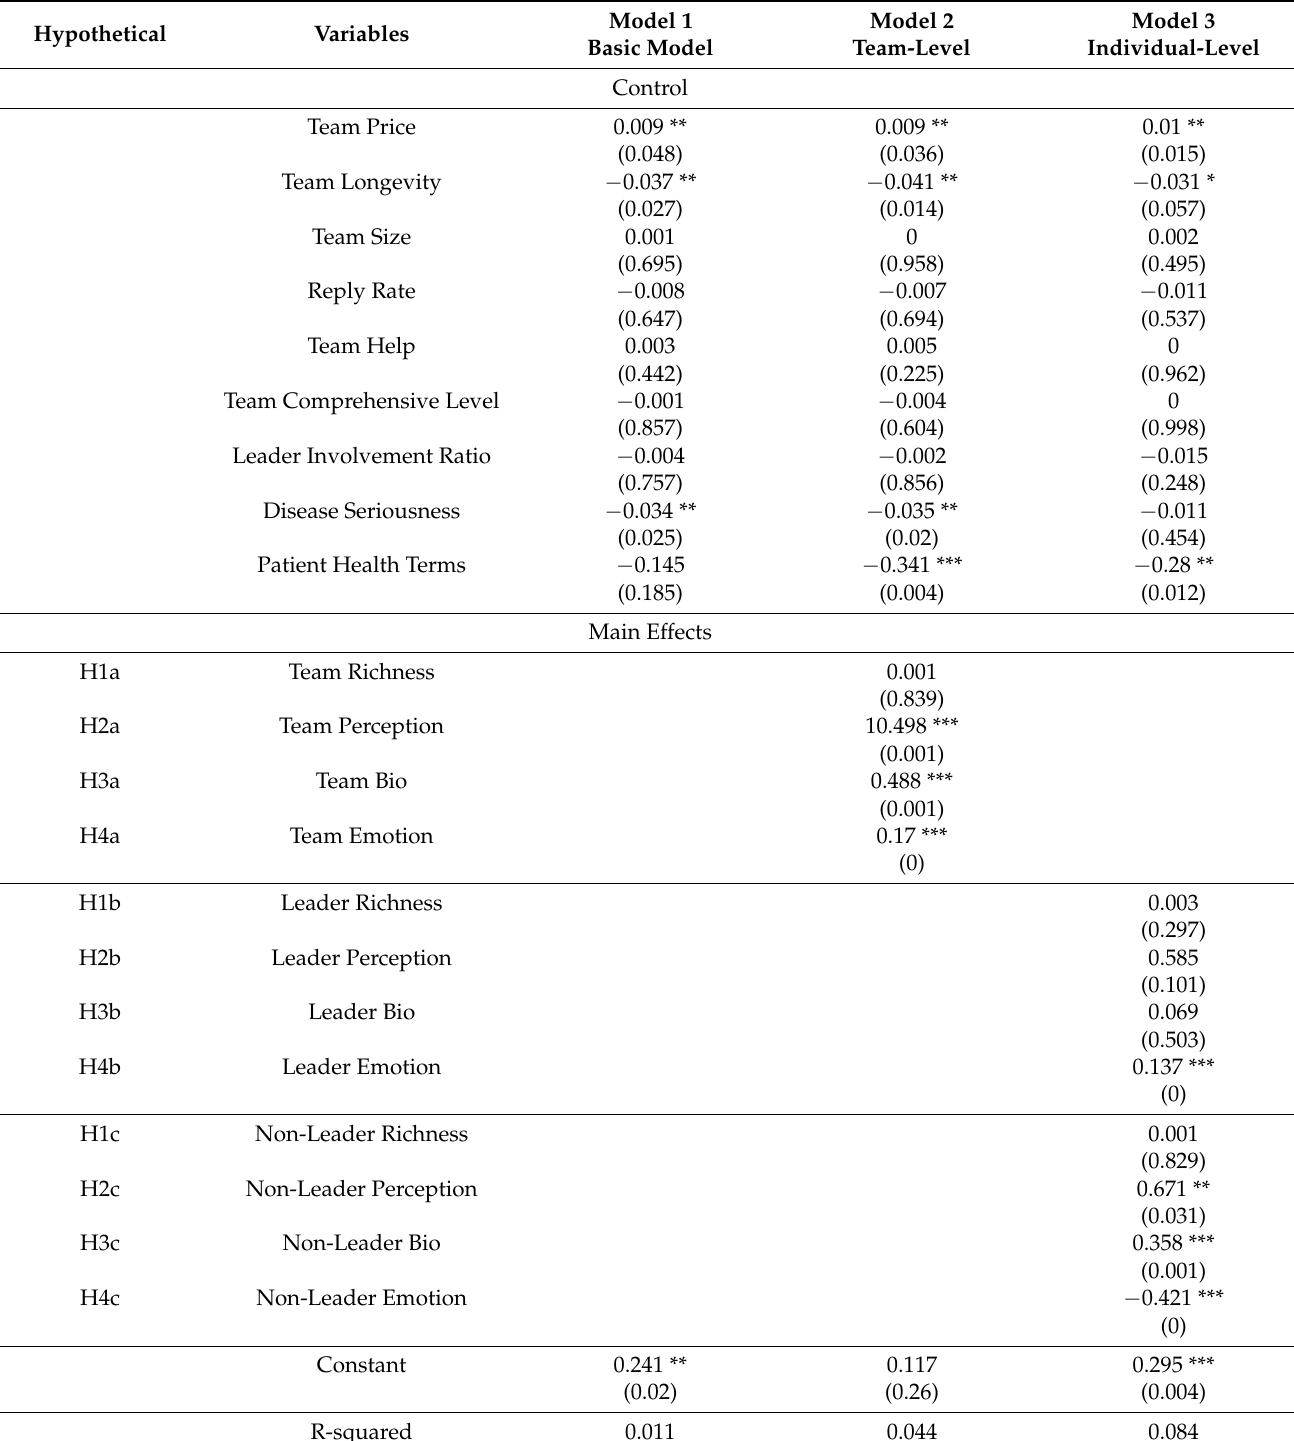
Table 7. Results of the regression model—patients’ emotional well-being (n =